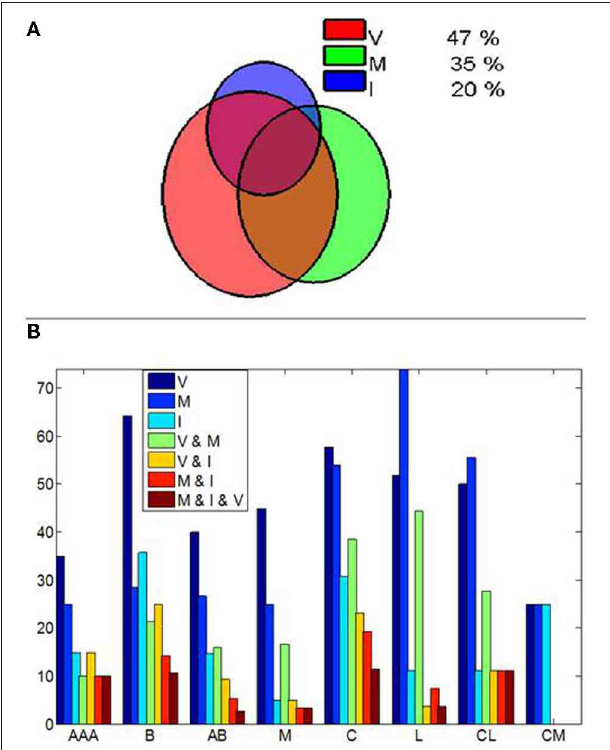
FIGURE 2 | Cells in the amygdala modulate their responses by eye movements. (A) Venn diagram illustrating the proportion of amygdala cells showing visuo (V), motor (M) and Image (I) selective modulation. A cell showing motor selective modulation is defined as a cell which significantly modify ( p < 0 . 01, Mann–Whitney U -test) its mean discharge rate between the saccades and fixation periods detected from fixspot presentation to the end of image viewing. (B) Interamygdalar distribution of cells as a function of the anatomical nuclei. Nuclei were split into: AAA, Accessory amygdaloid area; B, Basal nuclei; AB, Accessory basal division; M, medial division; C, Central division; L, Lateral Division; CL, Centrolateral division; CM, Central medial division. Note that cells showing selectivity in two or more categories are indicate by the and symbol, i.e., V and M indicates cells showing simultaneous visual and motor modulations in firing rate . While visual cells are dominant in the medial, basal, and accessory basal nuclei, motor-related effects are dominant in the lateral nuclei and the lateral division of the central amygdala. The proportion of cells with visual and motor modulation is similar in the central and medial division of the central amygdala. The combination of visuo-motor effects is also dominant in the central, and centrolateral divisions, the lateral nucli and the medial nuclei. Cells showing combined effects are indicated by the respective letters.